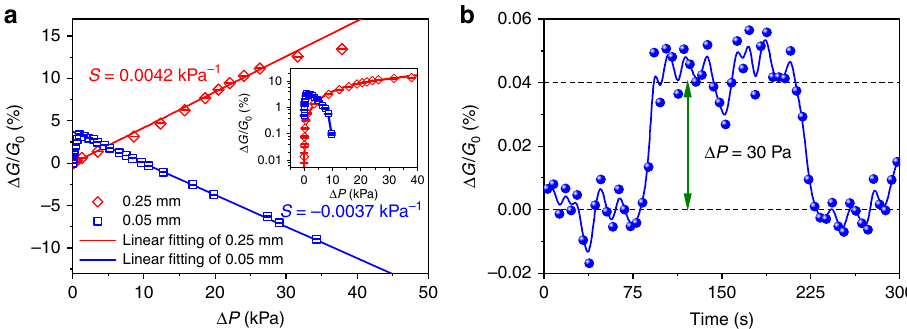
Fig. 3 Response characteristics of sensors with actuation membranes of different thicknesses. a Δ G / G 0 versus Δ P curves measured for the sensors having a 0.05-mm and a 0.25-mm-thick PET membrane. The inset is the logarithmic form of Δ G / G 0 . A pressure difference as tiny as 10 Pa could be discriminated. Error bars represent the s.d. of the conductance. b Real-time transient Δ G / G 0 of the sensor having a 0.25-mm-thick PET membrane responding to a 30-Pa differential air pressure impulse. Source data are provided as a Source Data fi